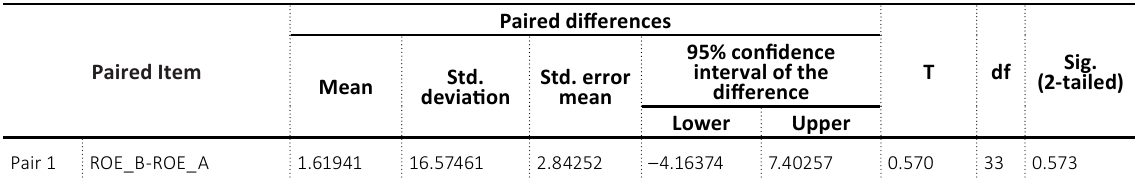
Table 4. ROE paired samples